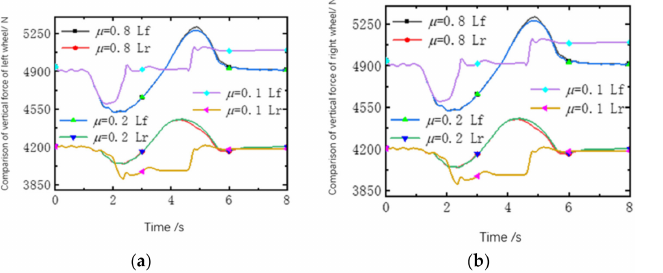
Figure 9. Comparison of vertical forces on wheels. ( a ) vertical force of left wheel; ( b ) vertical force of right